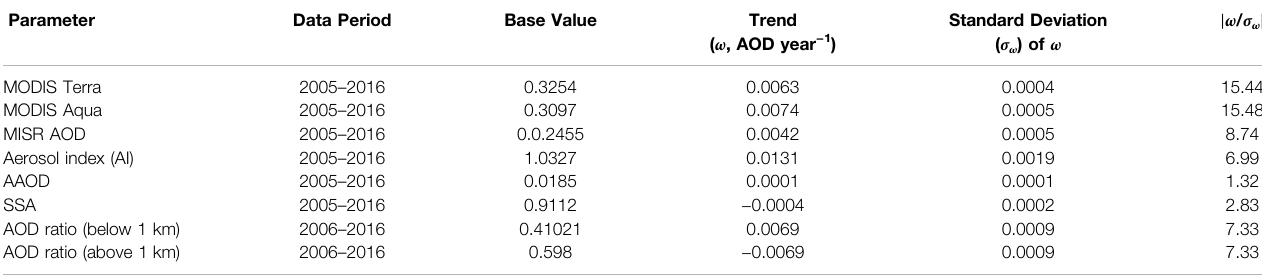
TABLE4| Regionalestimationsoftrendsoverthe1-degreegridboxsurroundingthepresentobservationalsite,usingsatellitedatasetsfortheyears2005 – 2016.Here,AOD observationsfrom MODISAqua, MODIS Terra,and MISRareused.Inaddition, OMIdatasets areusedforAAODandAerosolIndex andSingle Scattering Albedo(SSA). CALIPSO datasets are used to calculate AOD ratios over the study domain. The data statistics of the estimated trends are also given.